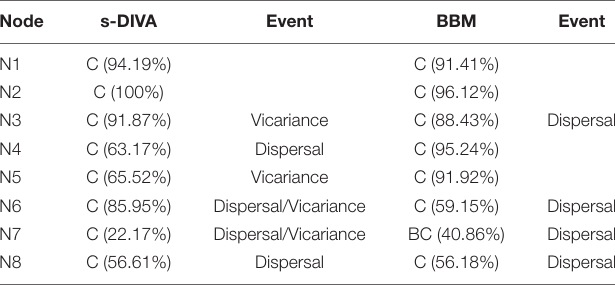
TABLE 3 | Biogeographic history of subtribe Artemisiinae inferred by reconstructing ancestral distributions with BBM and s-DIVA.